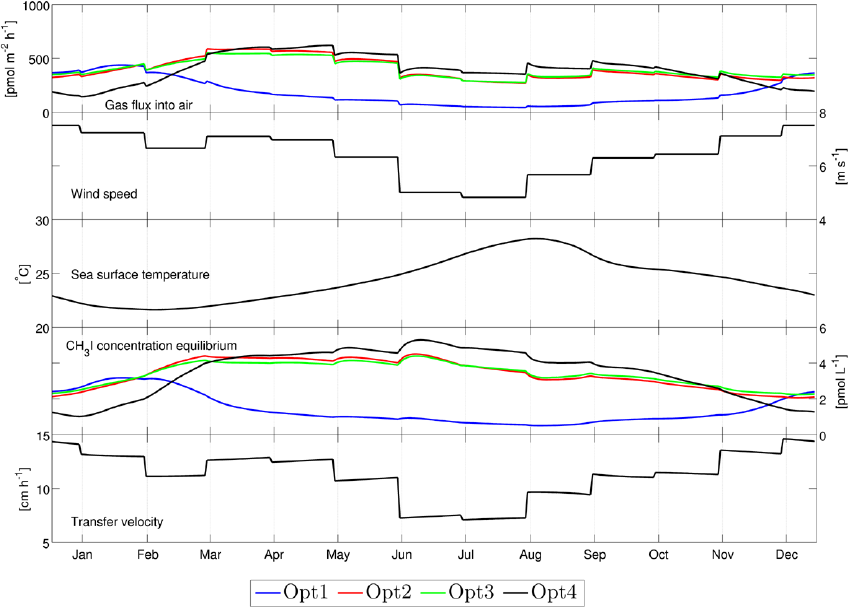
Fig. 5. Methyl iodide sea–air flux [pmolm − 2 h − 1 ], wind speed [ms − 1 ], sea surface temperature [ ◦ C], CH 3 I water and air concentration equilibrium c w − c a , [pmolL − 1 ], and gas transfer velocity [cmh − 1 H